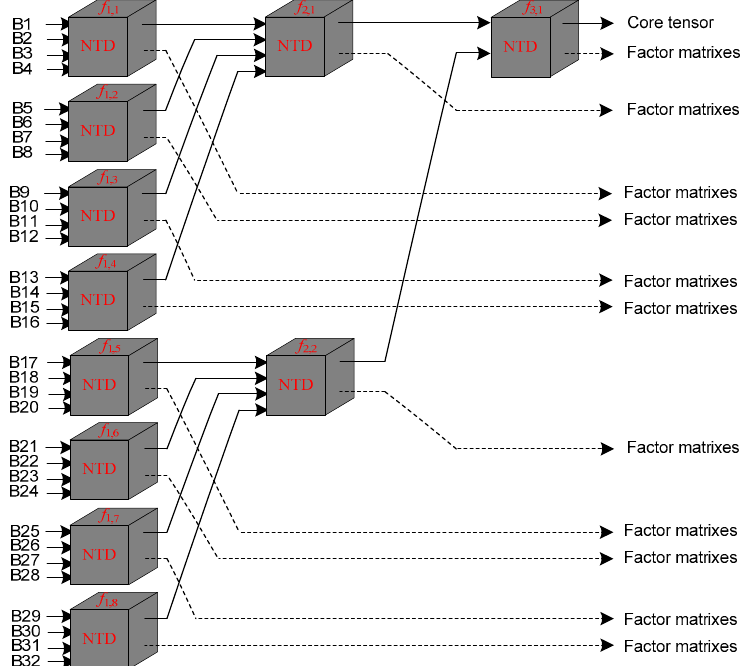
Figure 5. The multilevel NTD method when the band number is 32.